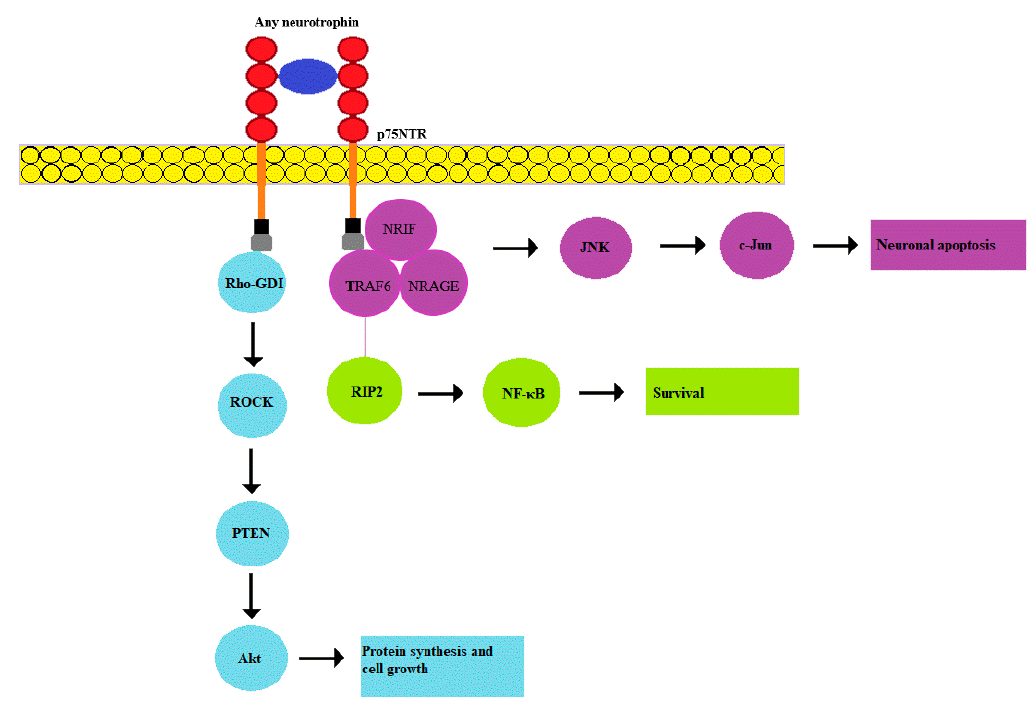
Figure 2. p75NTR is capable of low-affinity binding of any of the neurotrophic factors. The binding of pro-BDNF in combination with sortilin causes the involvement of NRIF, TRAF6, and NRAGE proteins, which activates the JNK-associated pathway. When binding BDNF to p75NTR in the TrkB complex, the RIP2/TRAF6-mediated path is initiated, which leads to NF-KB activation. In addition, p75NTR interacts with the Rho family of proteins, whose activation mediates the activity of Rho- associated protein kinase (ROCK), which subsequently leads to activation of the Akt pathway. RIP2— receptor-interacting serine/threonine-protein kinase 2; NRIF—neurotrophin receptor interacting factor; TRAF6—tumor necrosis factor receptor associated factor 6; NRAGE—neurotrophin receptor- interacting MAGE homologue.